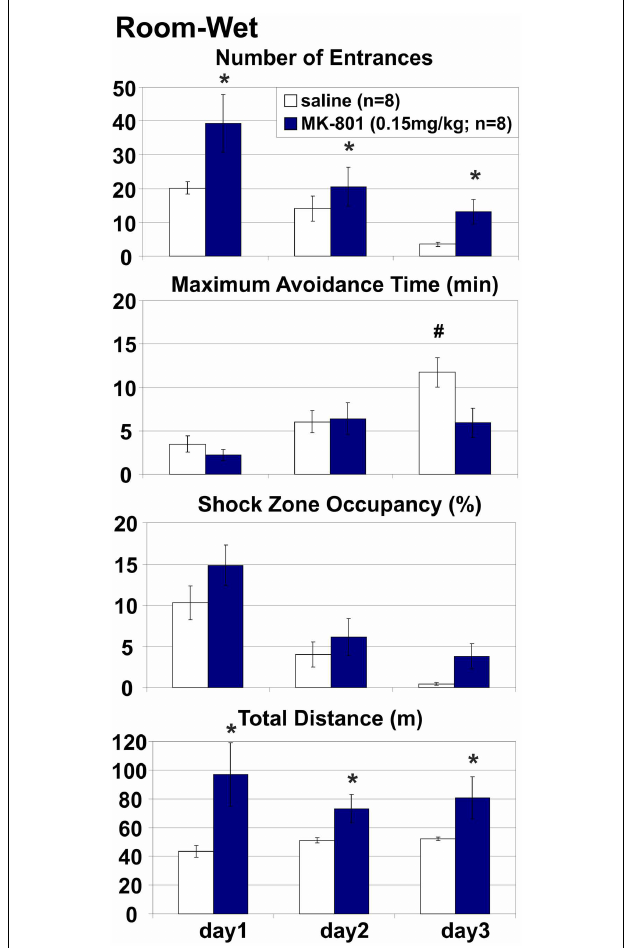
FIGURE 4 | Room-Wet place avoidance with rotating arena cues obscured by shallow water .The demand for coordination was reduced but not eliminated because arena-bound visual stimuli, path integration, and idiothetic information remained available. MK-801 (0.15mg/kg) increased the number of Entrances, but the effect of treatment on other measures of avoidance did not reach significance. All rats improved their performance during training. *Significant effects of treatment; # significant effect of treatment × session